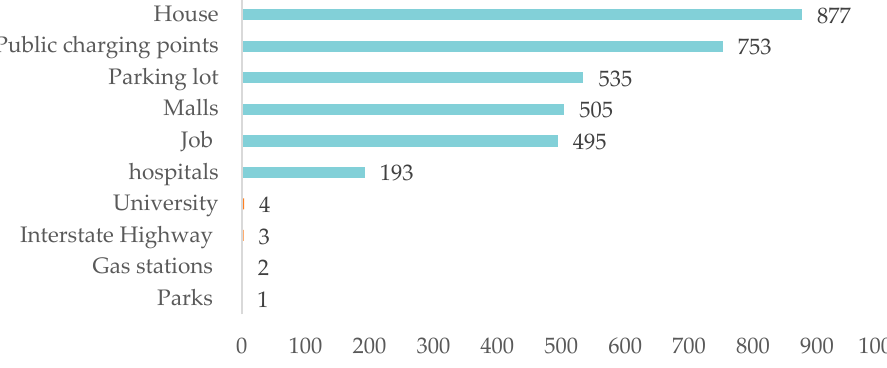
Figure 9. Preferred places by users for EV recharges.